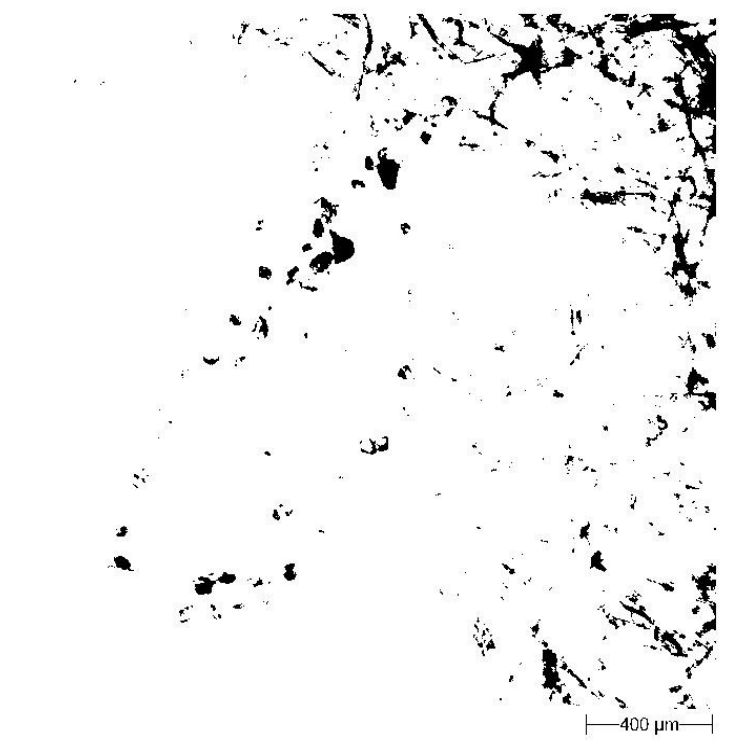
Figure 3. The same soil particles as Figure 2 after filtration of the blotting paper texture at the 0.32 grey